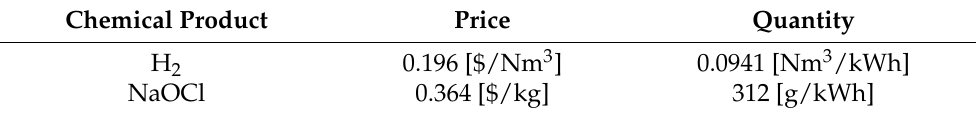
Table 11. Price and quantity of chemical